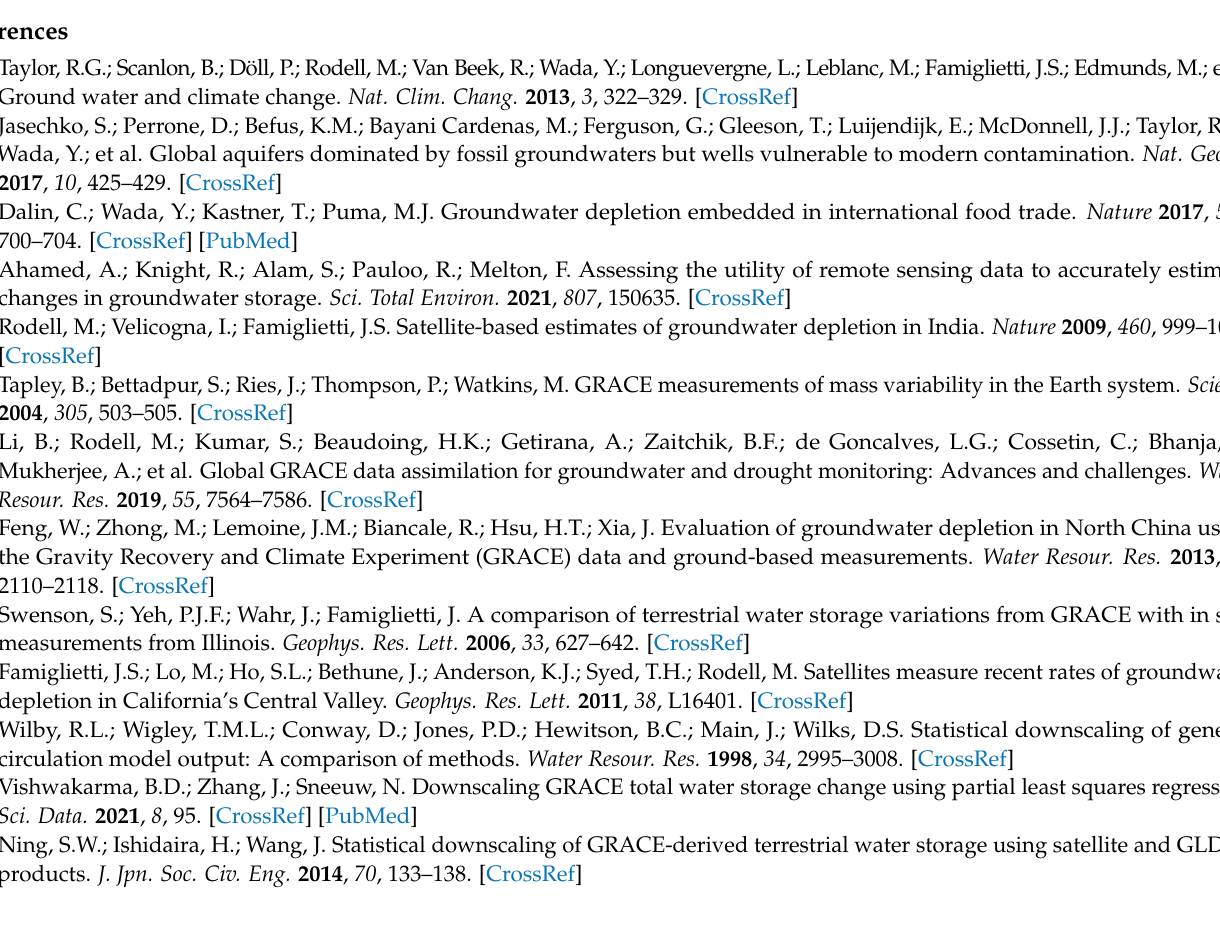
Figure S3: Effects of different forcing data combinations on simulated groundwater storage